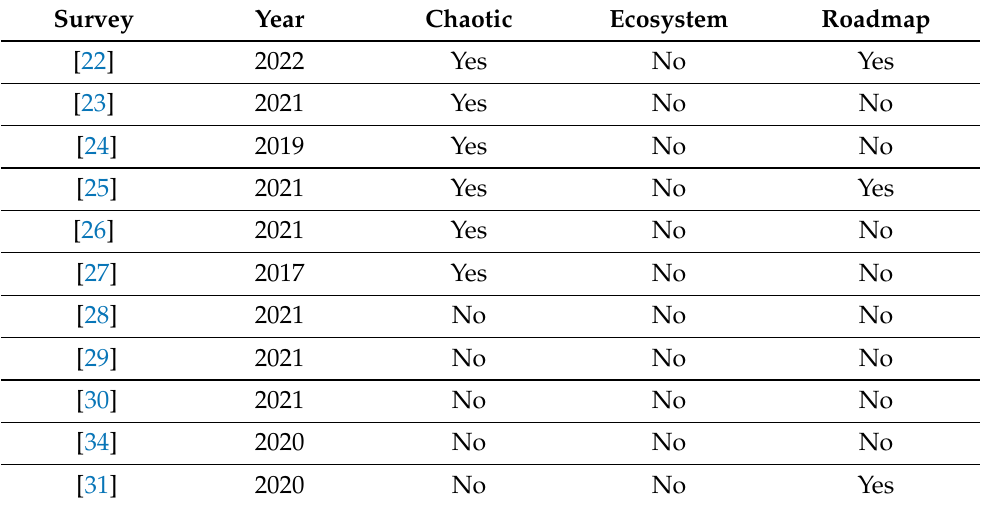
Table 1. Cont . Year Chaotic Ecosystem Roadmap